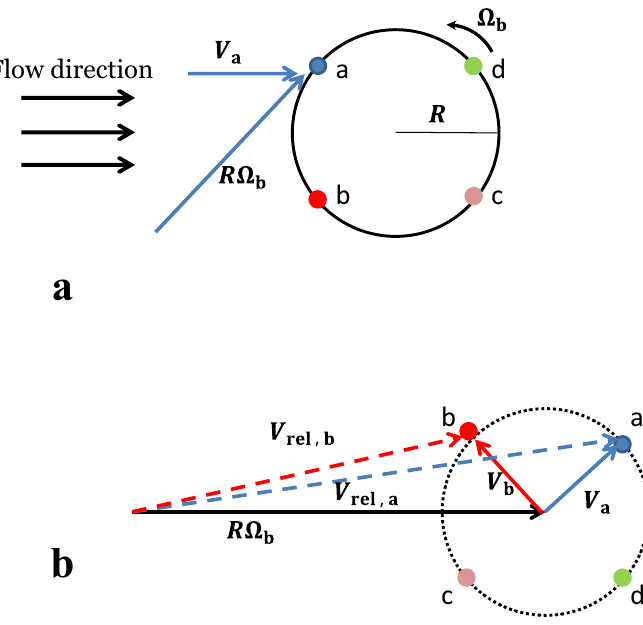
Figure 10. ( a ) A cross-sectional view of the flight path of the blades (black circle) and four azimuthal blade positions (colored circles); ( b ) the locus of the endpoint of relative velocity vector (dotted circle) and the corresponding velocity